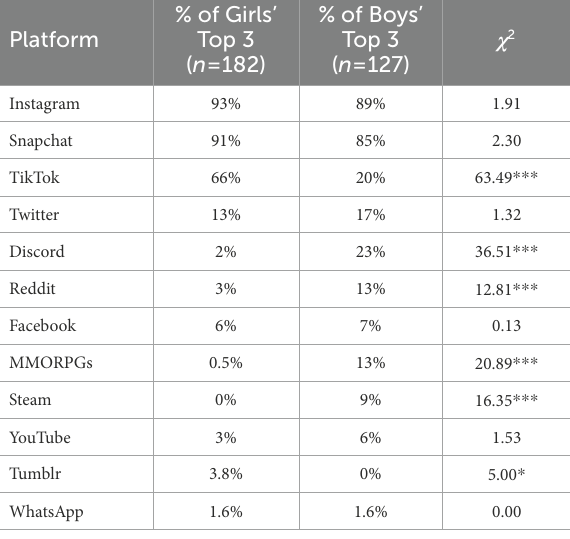
TABLE 1 Gender differences in adolescents’ top three social media platforms.